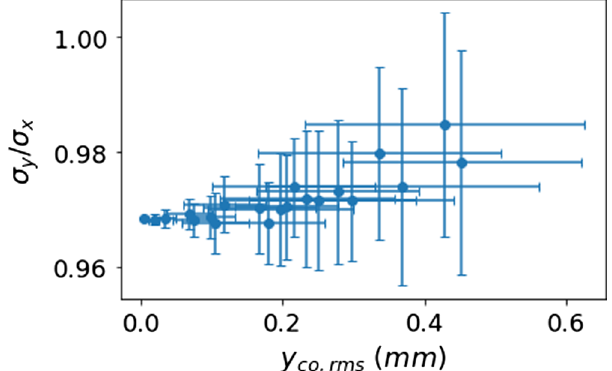
FIG. 13. Off-resonance scheme: ratio of the vertical and horizontal beam sizes varies with the vertical closed orbit distortions. The initial ratio of transverse beam sizes is σ = σ ≈ 0 . 97 , then a closed orbit that is increased gradually y x can slightly stretch the beam x − y profile vertically. Each error bar represents the standard deviation of 20 random